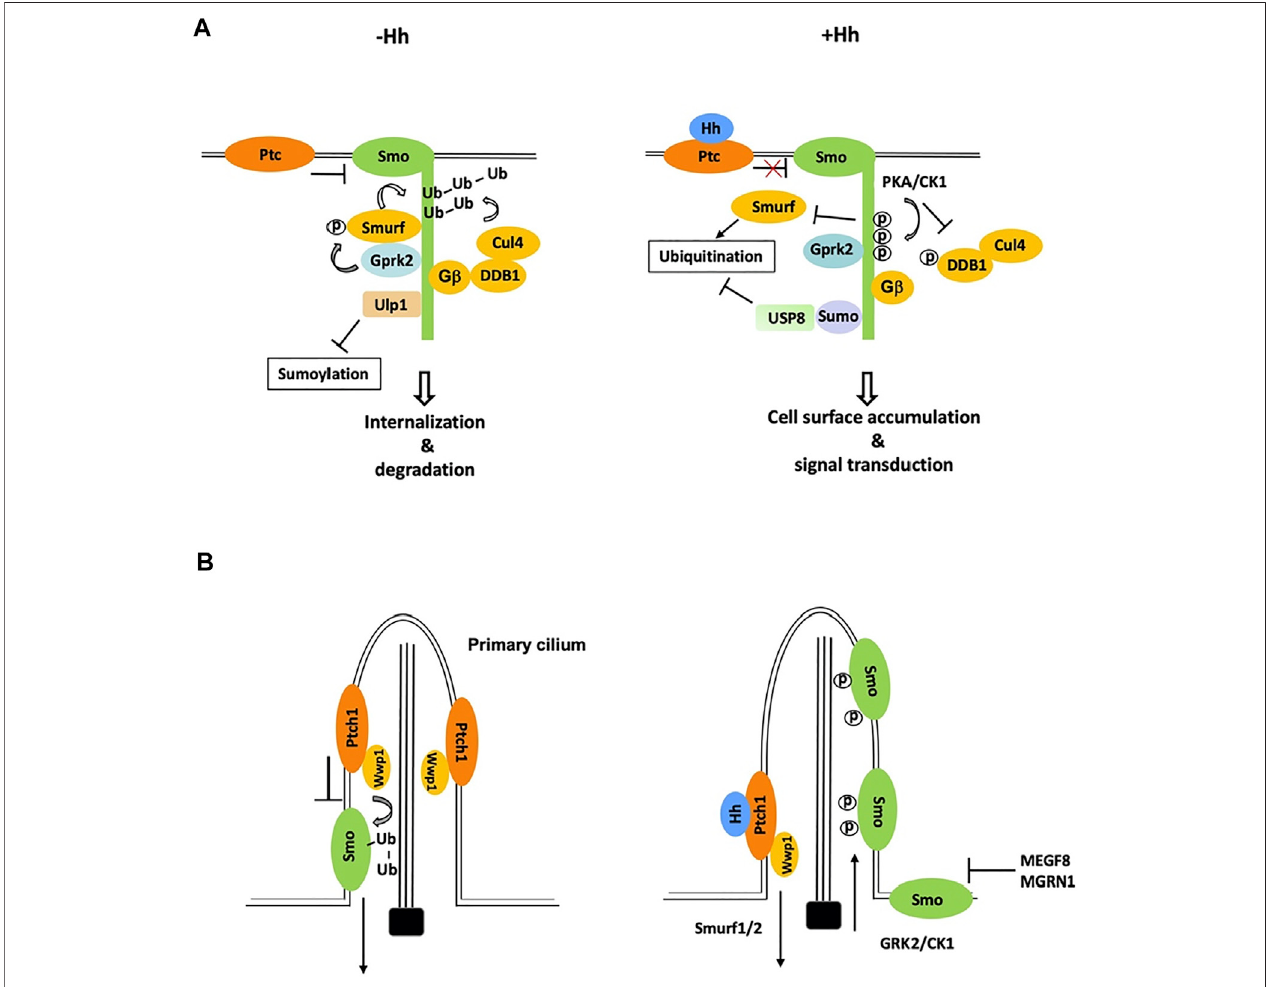
FIGURE 2 | Ubiquitination and sumoylation are involved in the regulation of Smo traf fi cking and stability. (A) In Drosophila cells not exposed to Hh, Smo is ubiquitinated by the Smurf family of E3s and other E3s including Cul4-DDB1-G β E3 complex, which promotes Smo endocytosis and degradation. Phosphorylation by Gprk2 stimulates the binding of Smurf to Smo. Binding of Ulp1 to Smo blocks its sumoylation. Hh stimulates phosphorylation of Smo and DDB1 by PKA to dissociate Smurf and Cul4-DDB1, respectively, and induces Smo sumoylation to recruit USP8, which blocks Smo ubiquitination, leading to Smo cell surface accumulation. (B) Inmammaliancells,Wwp1,whichislocalizedinprimaryciliathroughitsbindingtoPatch1,promotesSmoubiquitinationandciliaryexit.HhinhibitsSmoubiquitination bypromotingciliaryexitofPtch1andWwp1,leadingtociliaryaccumulationofSmo.Amembrane-associatedE3complexMEGF8/MGRN1promotesthedegradationof Smo to modulate cells ’ sensitivity to